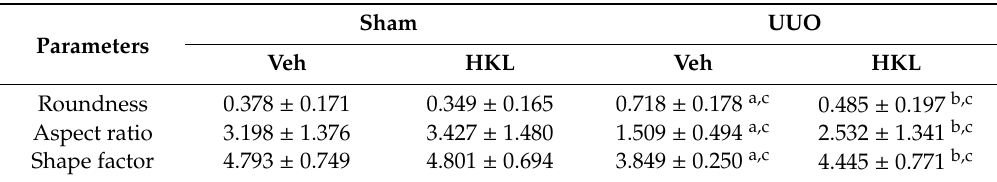
Table 1. Contour measurements of